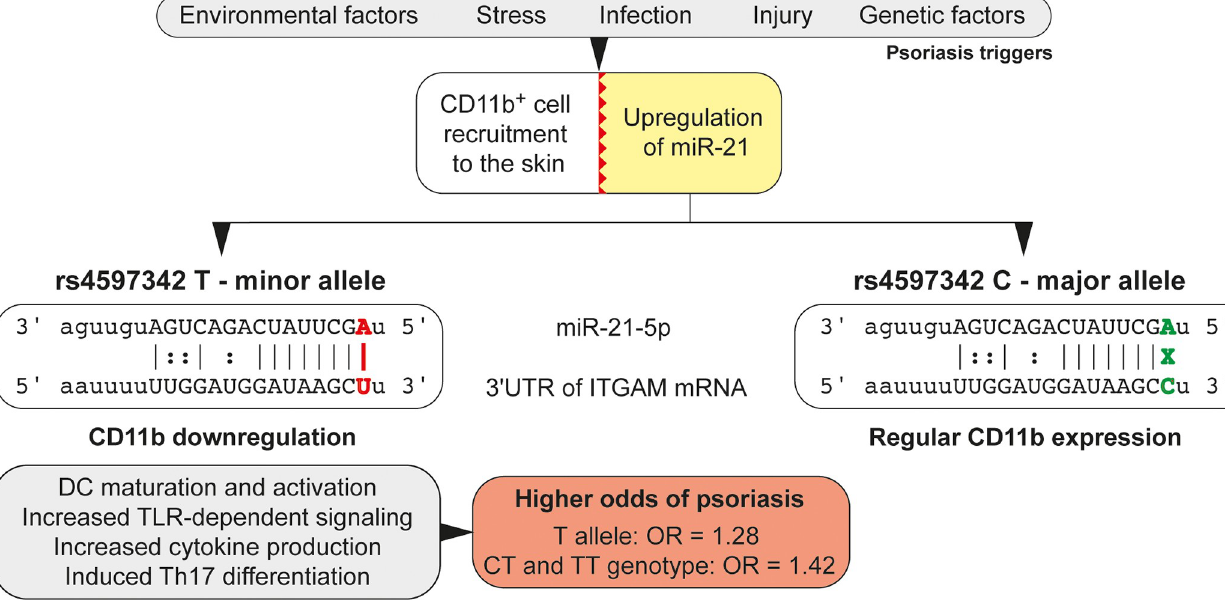
PLOS ONE | https://doi.org/10.1371/journal.pone.0218323 June 18,